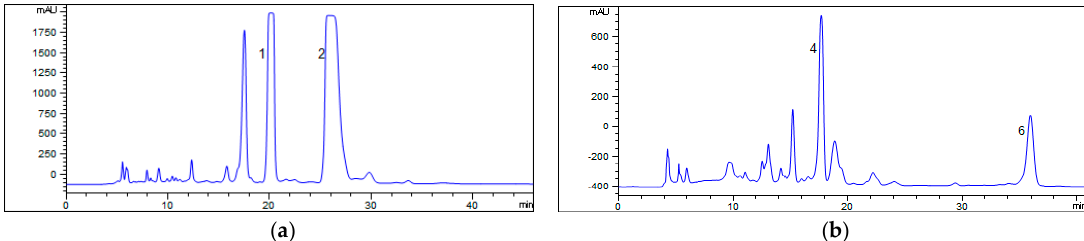
Figure 3. Preparative high-performance liquid chromatography (Prep-HPLC) chromatograms of fraction II ( a ) and fraction VI ( b ). Conditions: column, YMC-Triart C 18 (250 × 9.6 mm, i.d., 5 μ ); flow